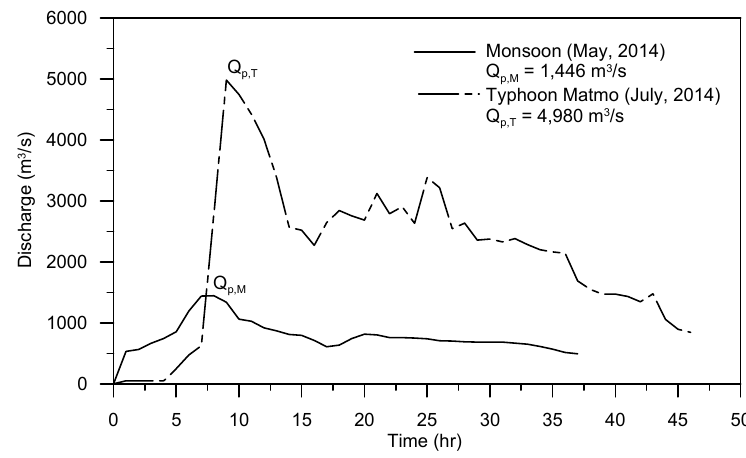
Figure 7. Flood hydrographs for Monsoon and Typhoon Matmo.